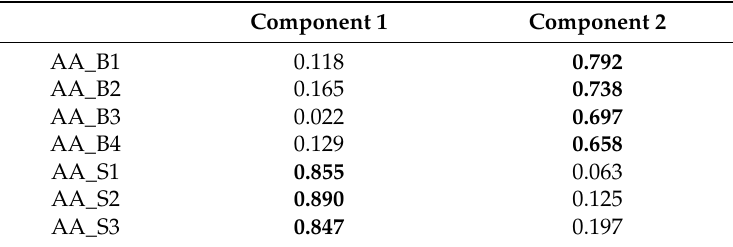
Table 4. Rotated component matrix of affective attitudes.